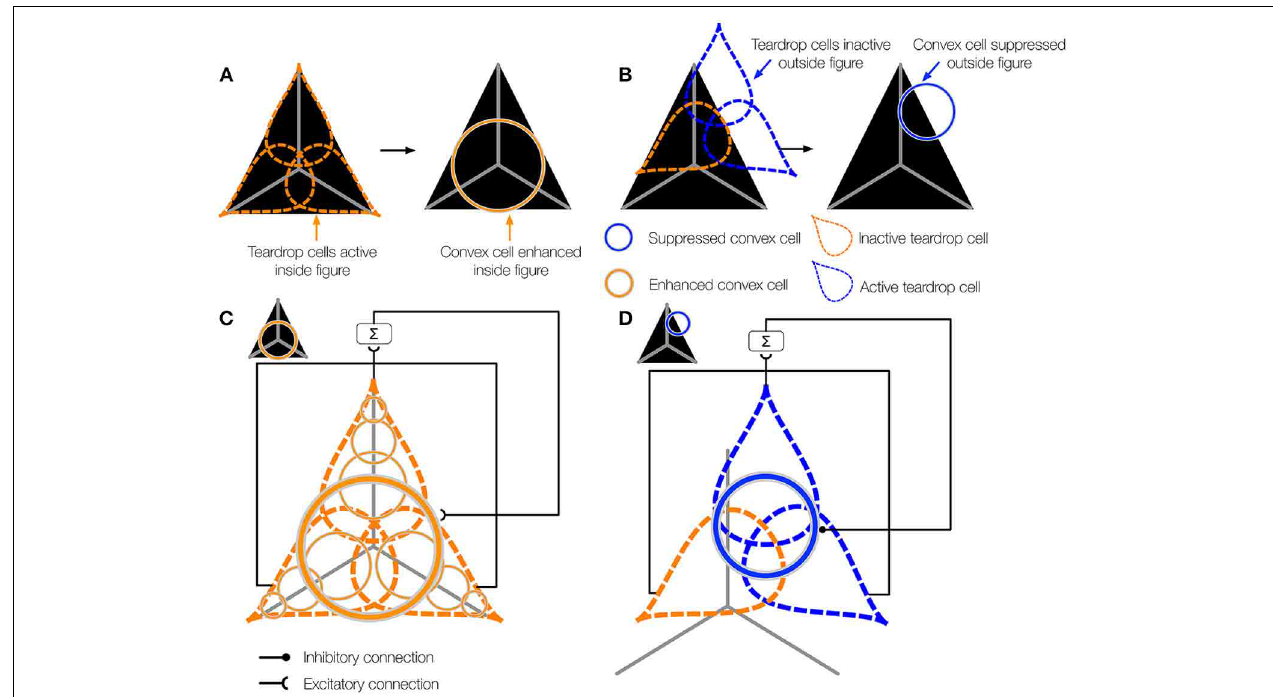
FIGURE 5 | The teardrop cell feedback circuit enhances convex cell activity along the medial axis of a figure. (A) Left panel: Three teardrop cells are shown (outlined by the dashed ellipses) that group convex cells with jittered RF sizes and positions along integration directions that coincide with the medial axis of the triangle figure. Right panel: Feedback from the active teardrop cells (orange) enhances the convex cell centered on the medial axis. (B) Left panel: Only the bottom left teardrop cell is active because a large segment of the medial passes within its RF. The medial axis does not enter the RF of the other two teardrop cells, so they are inactive. Right panel: The convex cell shown is inhibited because two of the three teardrop cells are inactive. (C,D) The teardrop cell feedback circuit mechanism. (C)